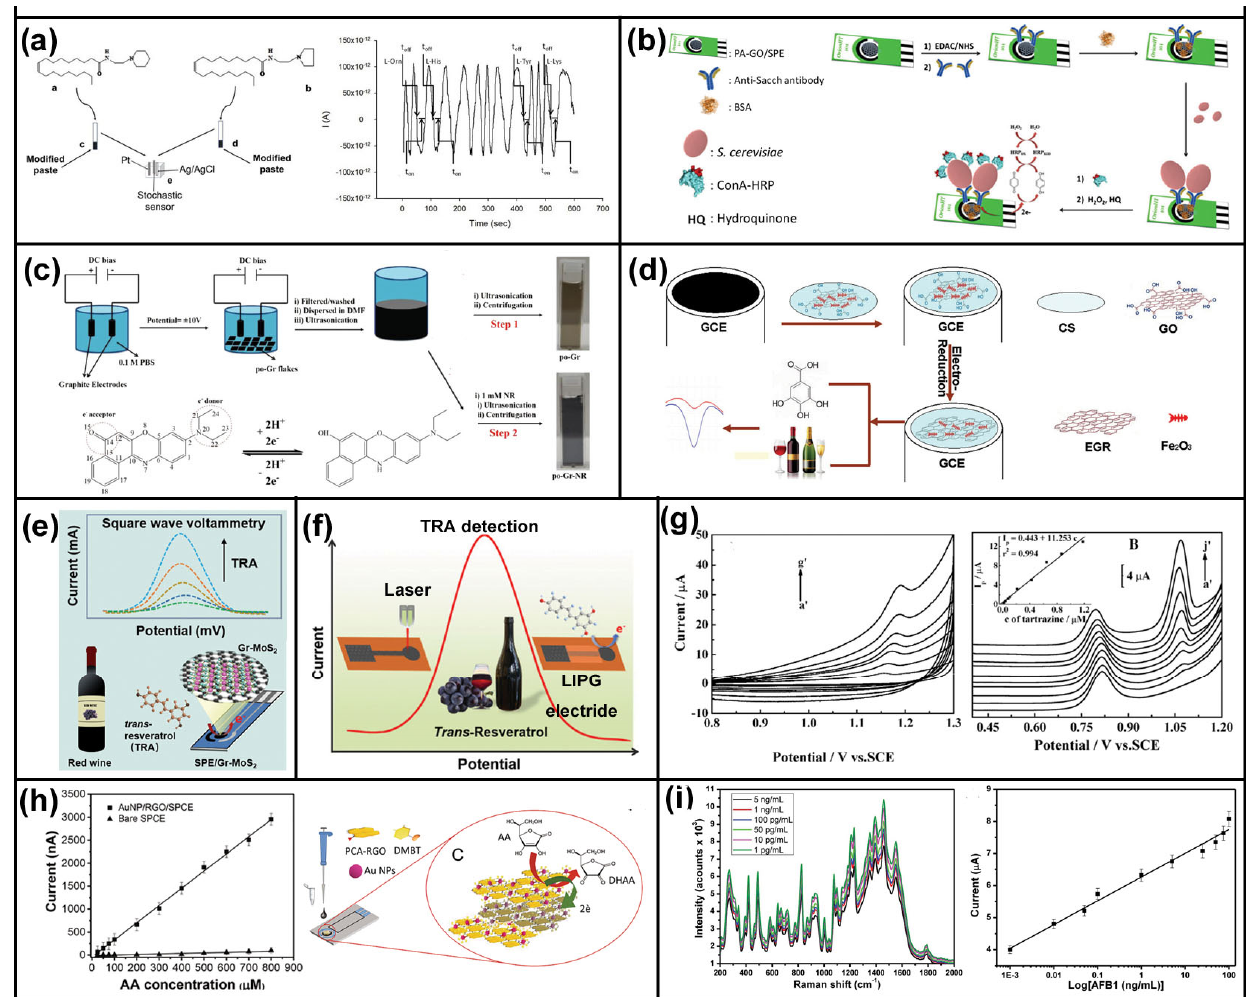
Figure 5. Graphene-based electrochemical sensors for food and alcoholic beverage safety. ( a ) The design of the electrochemical platform. Reprinted with permission from [100]. Copyright Wiley, 2019. ( b ) Schematic display of the steps involved in the preparation and performance of the im- munosensor for Sacch. Reprinted with permission from [104]. Copyright Springer, 2018. ( c ) Electro- chemical synthesis of po-Gr and treatment of NR with po-Gr. Reprinted with permission from [108]. Copyright Elsevier, 2017. ( d ) Illustration for the fabrication of CS–fFe 2 O 3 –ERGO/GCE and its appli- cation for the detection of GA in wines. Reprinted with permission from [101]. Copyright Elsevier, 2015. ( e ) Two-dimensional nanocomposite-based electrochemical sensor for rapid determination of trans-resveratrol. Reprinted with permission from [106]. Copyright Elsevier, 2020. ( f ) Schematic il- lustration of the preparation of LIPG-based electrochemical sensor for the detection of TRA in red wines and grape skins. Reprinted with permission from [105]. Copyright Elsevier, 2020. ( g ) CV curves and the possible electrochemical reaction mechanism of sunset yellow and tartrazine. Re- printed with permission from [109]. Copyright Elsevier, 2013. ( h ) Sketch of the AuNP/RGO/SPCE- modified nanostructured platform and its application for AA determination in milk. Reprinted with permission from [112]. Copyright Elsevier, 2020. ( i ) Raman spectrum and CV curves for different concentrations of AFB1. Reproduced with permission from [113]. Copyright PLOS, 2019.